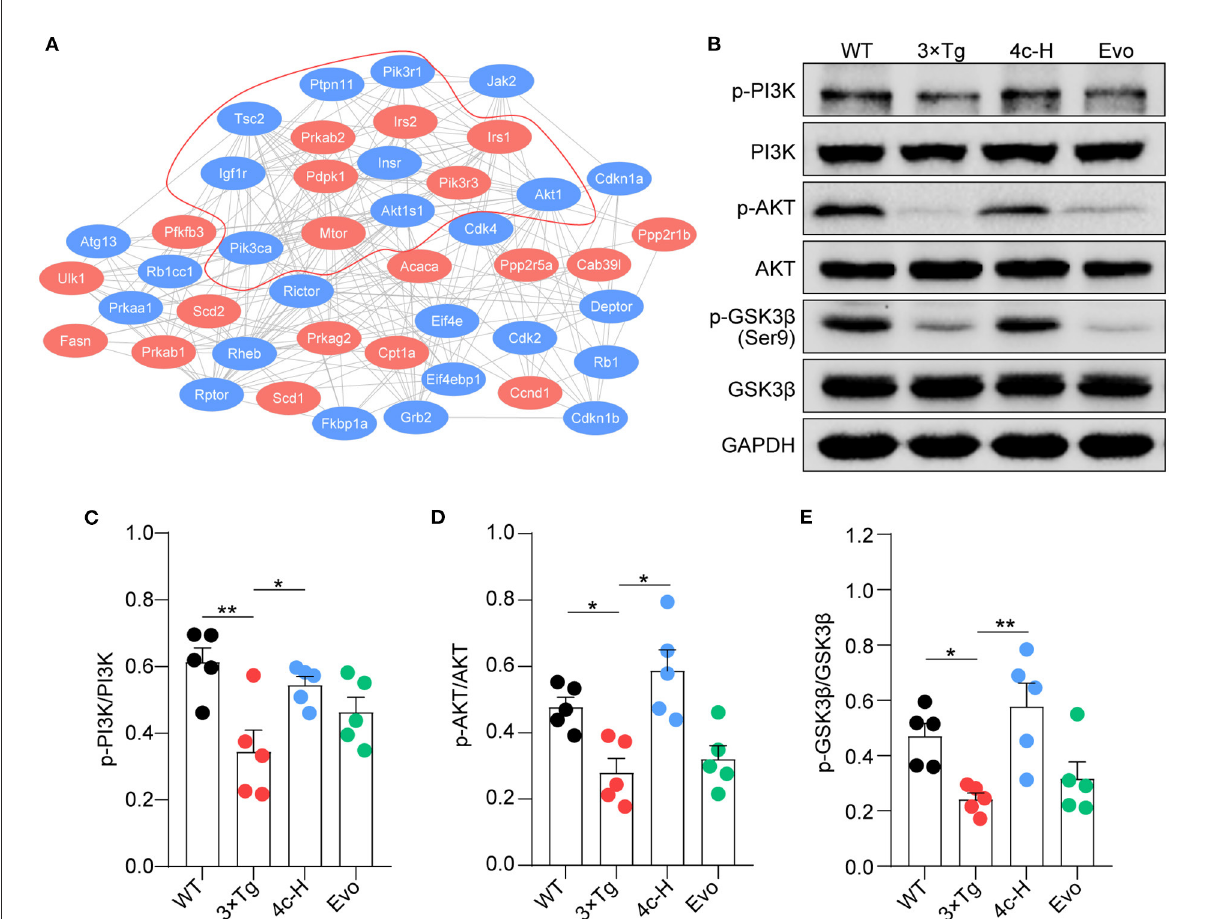
FIGURE8 Compound 4c activates the PI3K/AKT/GSK3 β signaling pathway. (A) Protein–protein interaction network involving the AMPK signaling pathway. Compound 4c affected the 19 proteins shown in red, and 25 interacting proteins identified by the STRING search are shown in blue. (B) Effects of 4c treatment on p-PI3K, p-AKT, and p-GSK-3 β protein expression in 3 x Tg mice. (C–E) Relative protein abundance of p-PI3K/PI3K, p-AKT/AKT, and p-GSK3 β /GSK3 β in each group. Data are the mean ± SEM, n = 5; * P < 0.05 and ** P < 0.01 as indicated in the